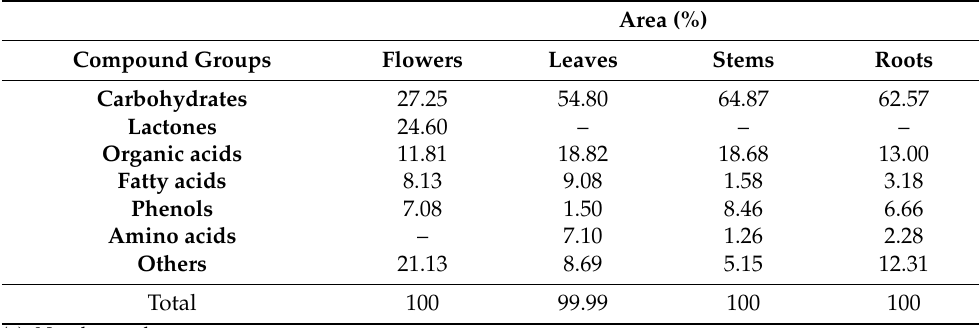
Table 3. Carbohydrate composition of derivatized methanolic extracts obtained by GC-MS.